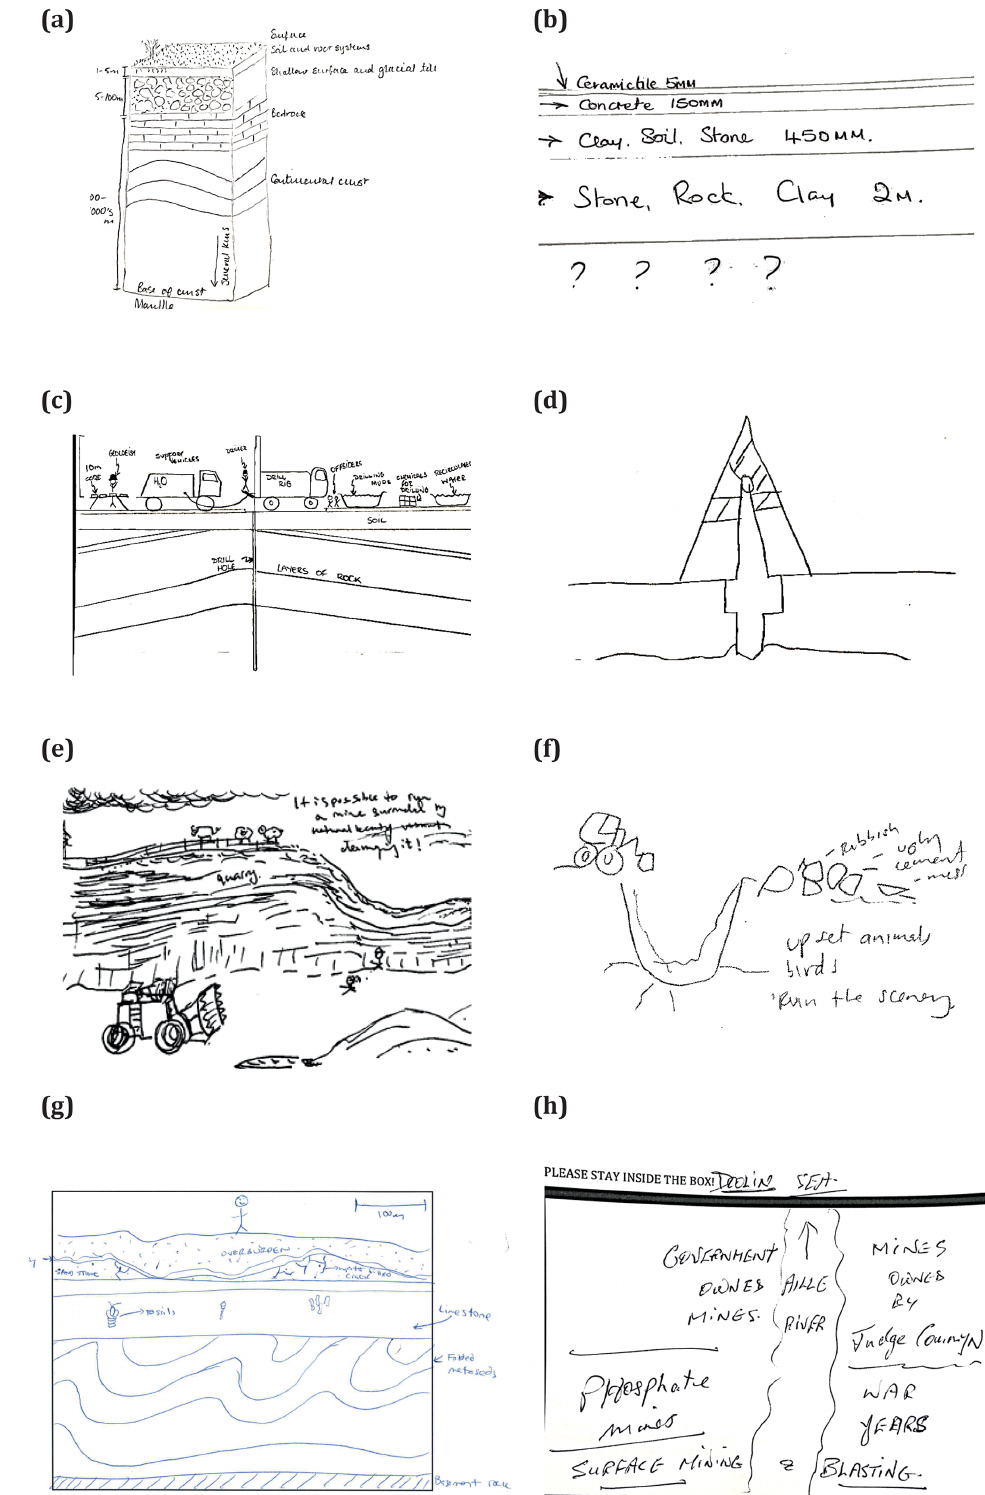
Figure 1. Comparison of sketches made by geoscientists (a, c, e, g) and non-geoscientists (b, d, f, h) . The sketches are of (a, b) the subsurface, (c, d) drilling, (e, f) mining/quarrying, (g, h) subsurface (g) , and mining/quarrying (h)